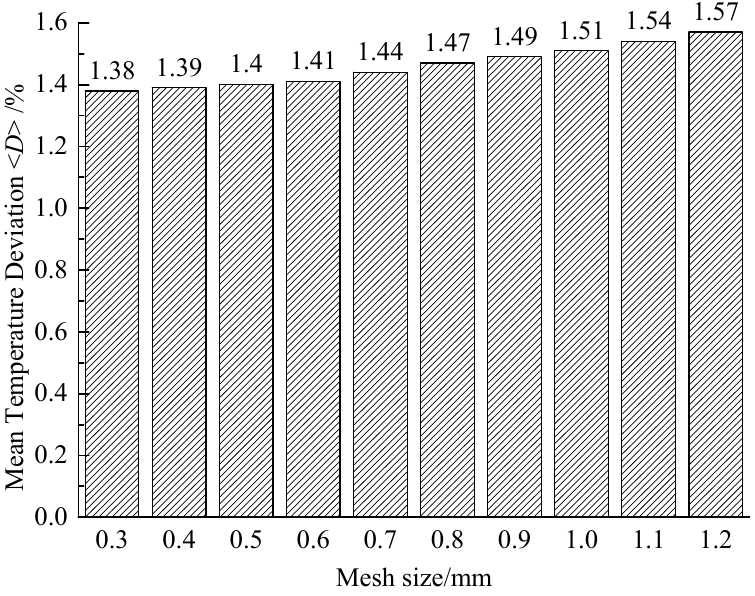
Figure 13. The effect of mesh size on mean deviation < D > from NPCTF or JRC = 16.34 fracture.